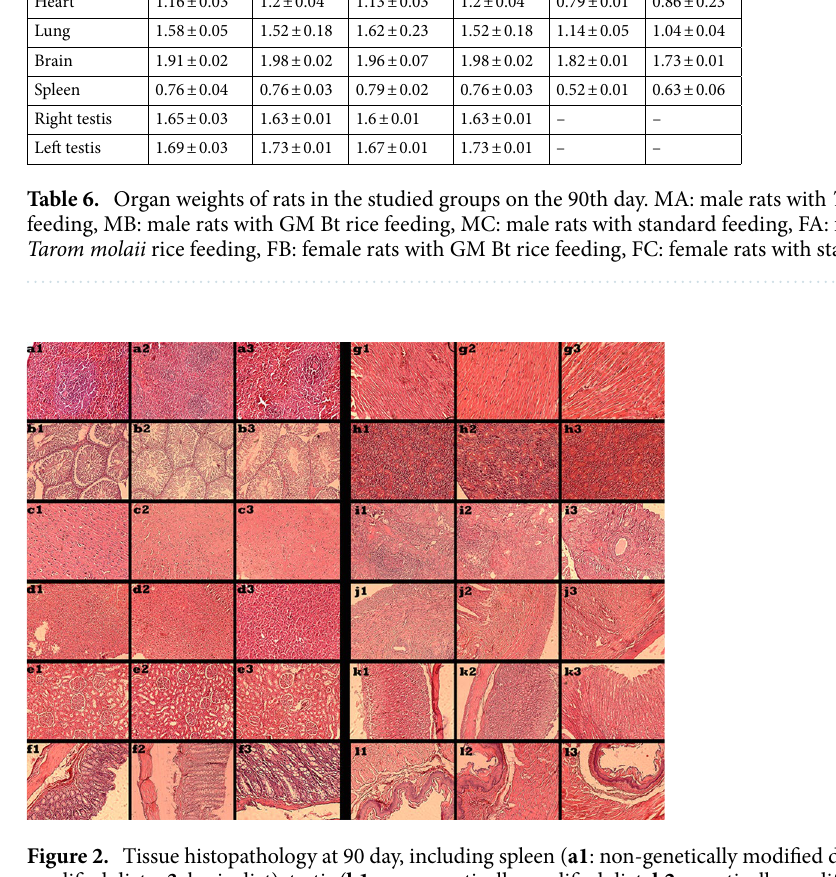
Figure 2. Tissue histopathology at 90 day, including spleen ( a1 : non-genetically modified diet, a2 : genetically modified diet, a3 : basic diet), testis ( b1 : non-genetically modified diet, b2 : genetically modified diet, b3 :